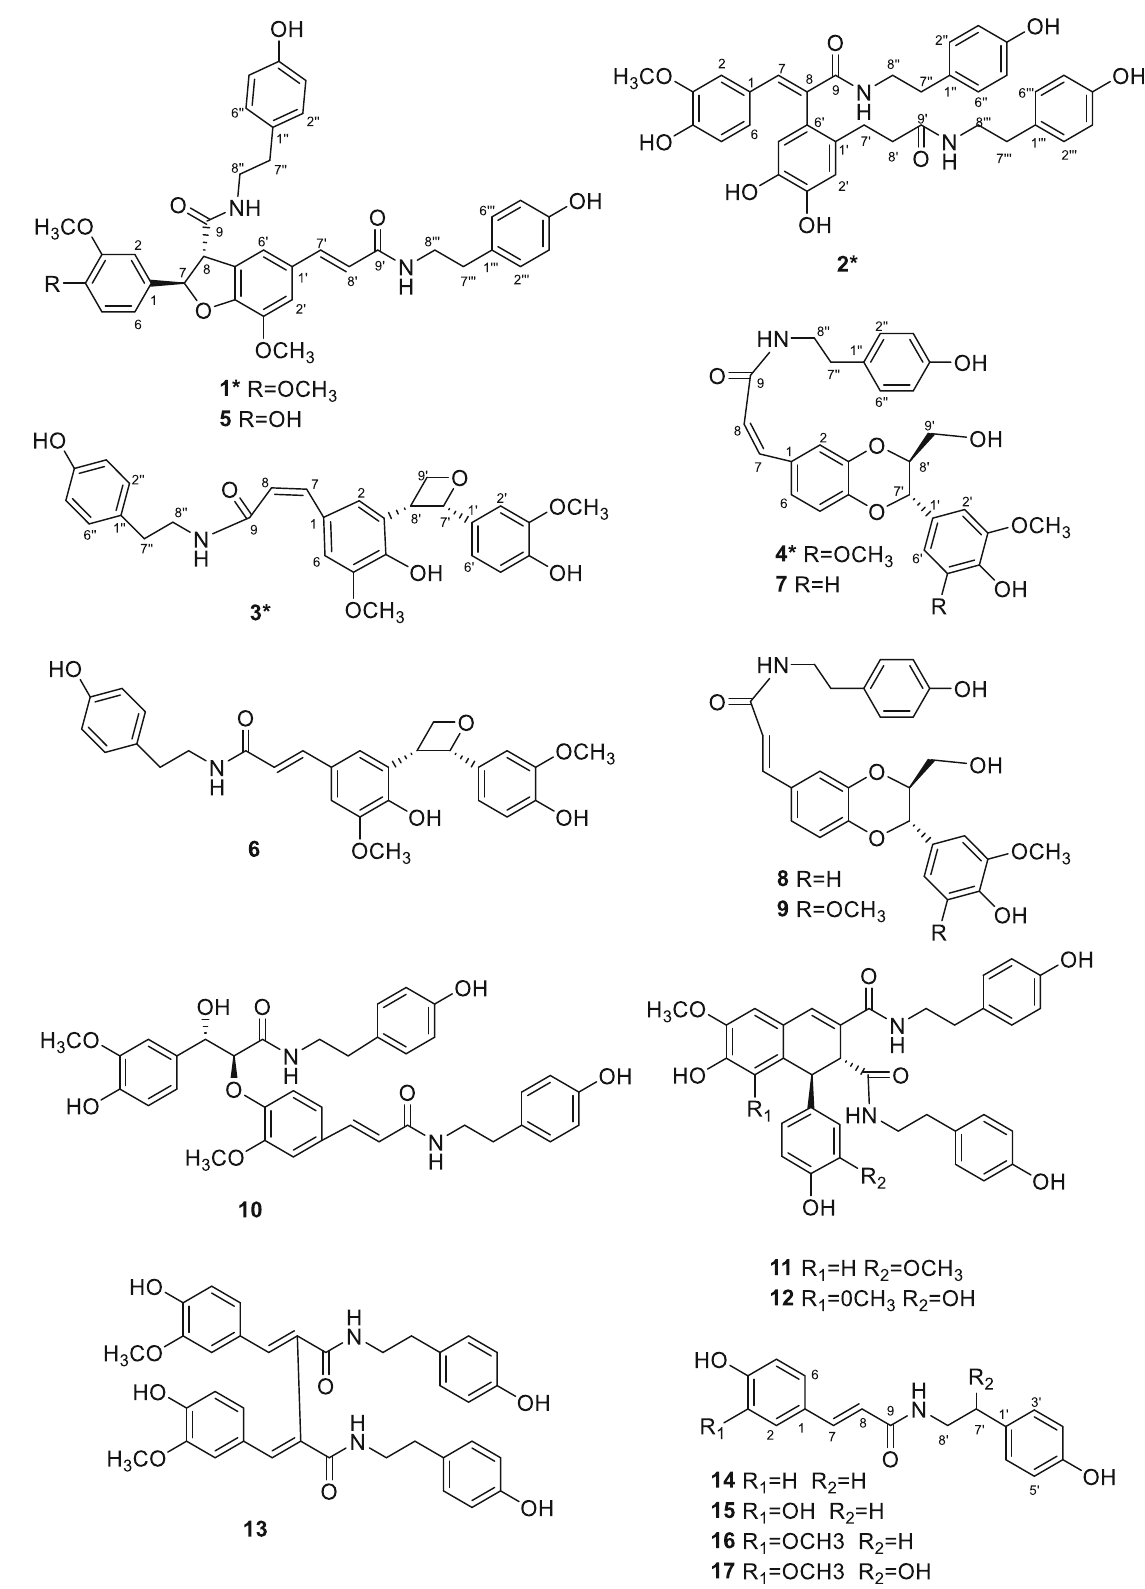
Fig. 1 Structures of compounds 1 –